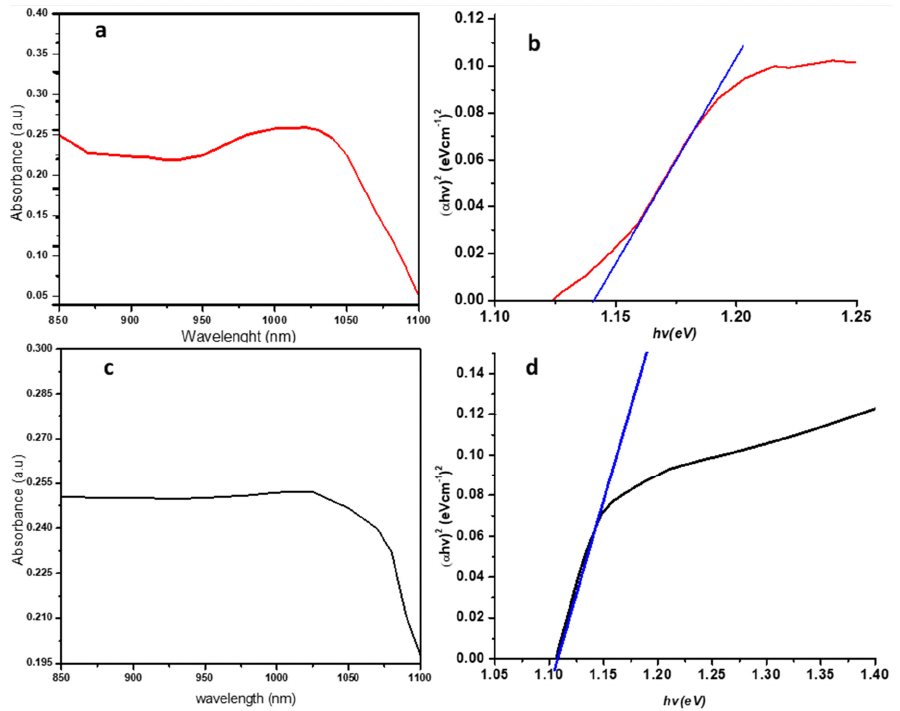
Figure 3. UV-Vis-NIR (Ultra Violet-Visible-Near Infrared) absorption spectrum ( a , c ) and Tauc ( b , d ) plot of the synthesized PbS nanoparticle (1) red and (2) black.